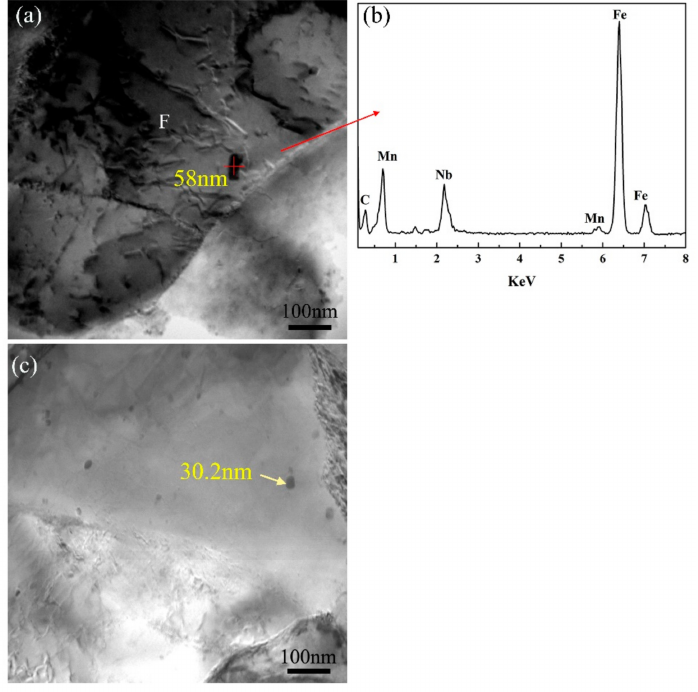
Figure 13. ( a ) TEM Microstructure of NbC precipitates with grain size of about 58 nm of the 650 ◦ C sample, ( b ) EDX spectra of NbC precipitates in ( a ), ( c ) TEM Microstructure of NbC precipitates with grain size of about 30.2 nm of the 650 ◦ C sample. F,